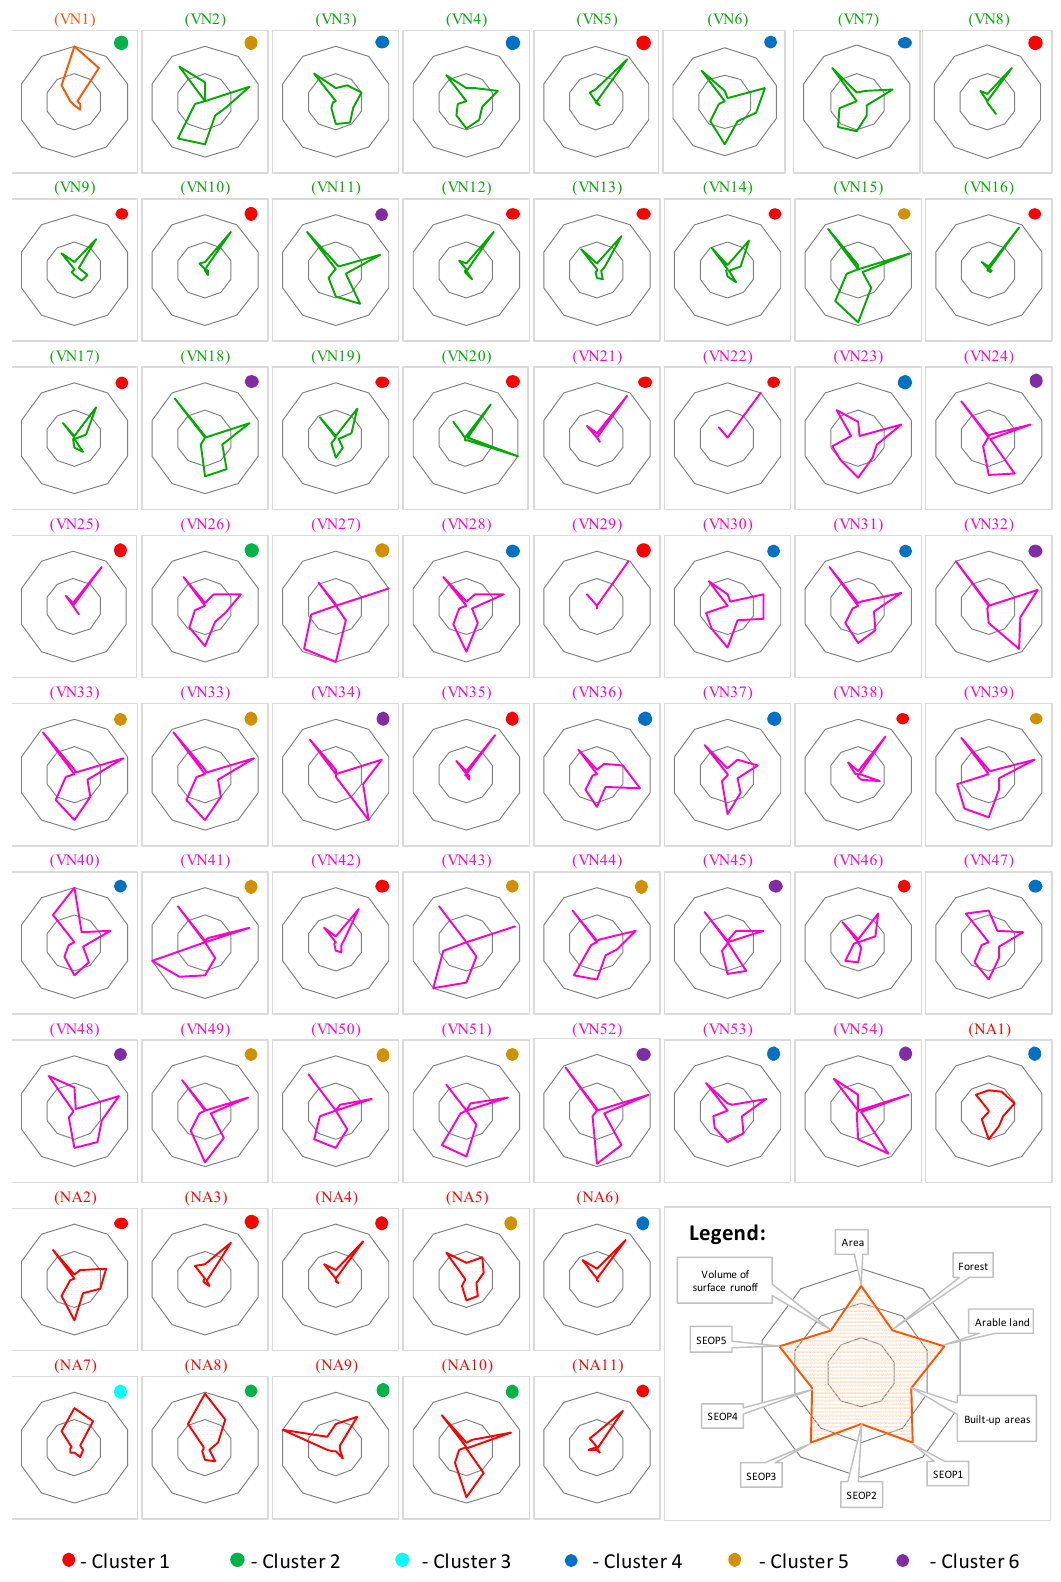
Figure 7. Graphic depiction of the set of individual reservoir data.